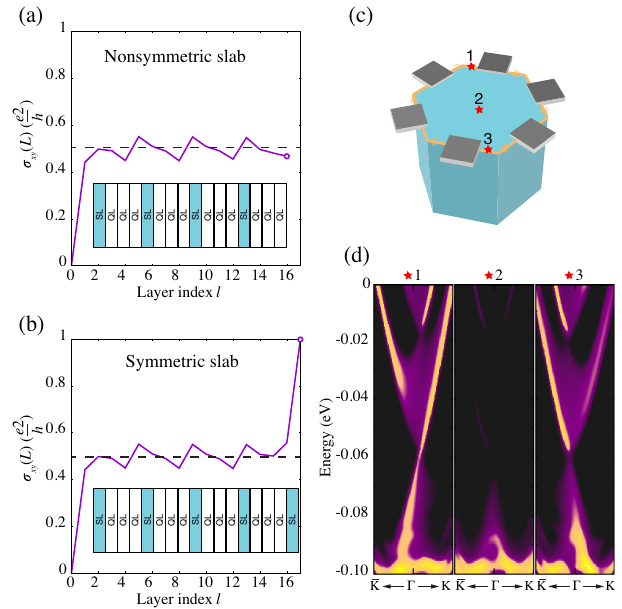
FIG. 4. Half-quantized surface AHC at the S termination. (a,b) Integrated, layer-projected, anomalous Hall conductance for the slabs with 16 and 17 vdW layers, respectively. The 16-layer slab is not symmetric, containing four unit cells as a half-magnetic topological insulator, while the 17-layer slab is symmetric with a global band gap and nontrivial Chern number, as shown in the insets. (c) Schematic plot for the nonlocal transport measurement with a hexagonal six-contact-probing setup. (d) Spectral func- tions at three spots denoted in panel (c), showing chiral hinge states at the S termination that manifest the half-QAH